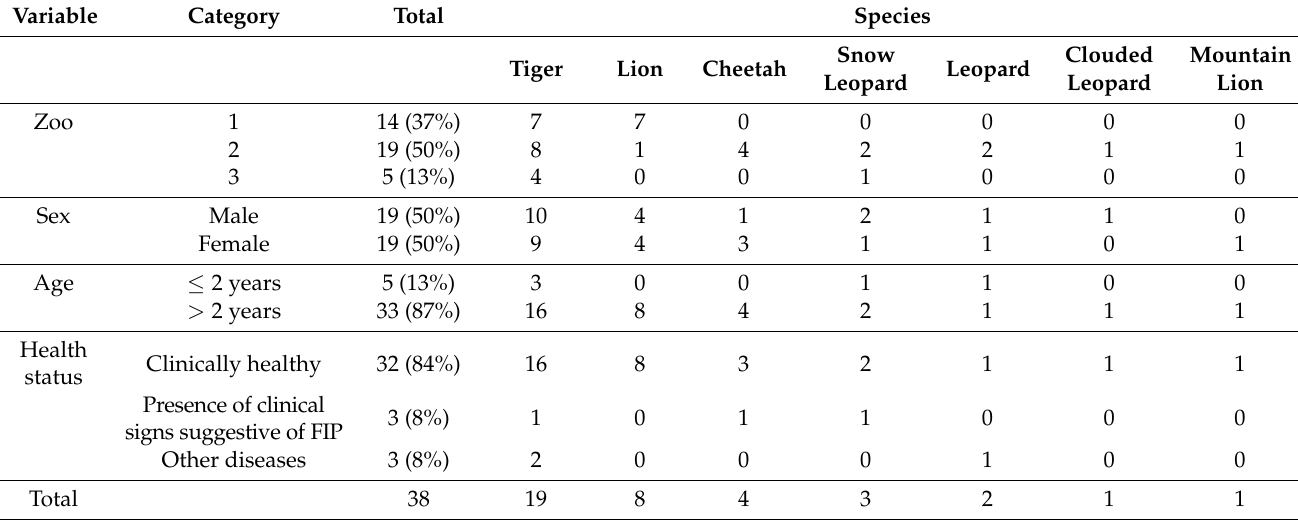
Table 1. Characterization of non-domestic felids analyzed in this study.